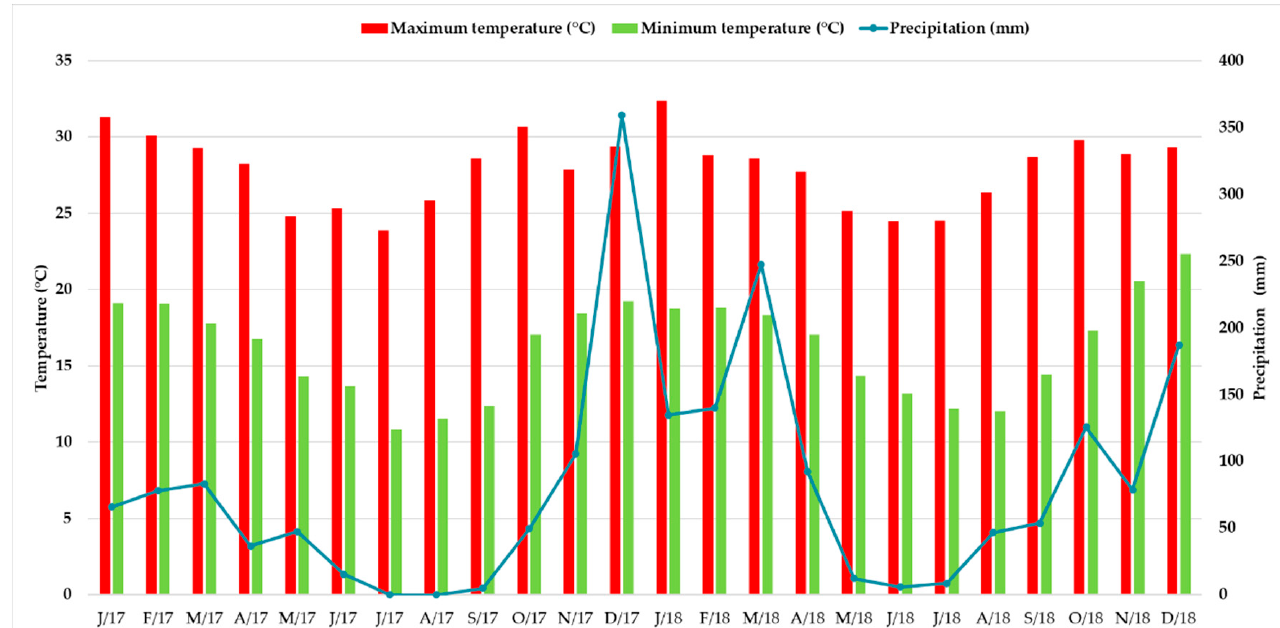
Figure 1. Weather data from January (J) 2017 to December (D) 2018, in Viçosa, Minas Gerais, Brazil. Source: INMET, 2019. The soil was classified as red–yellow dystrophic latosol [12]. Soil samples were collected with a probe from 0 to 10 cm layers in August 2016, and the chemical composition was analyzed (Table 1). Given the results, soil fertilization was carried out following the recommendations of [13]. There was no need for soil correction or potassium